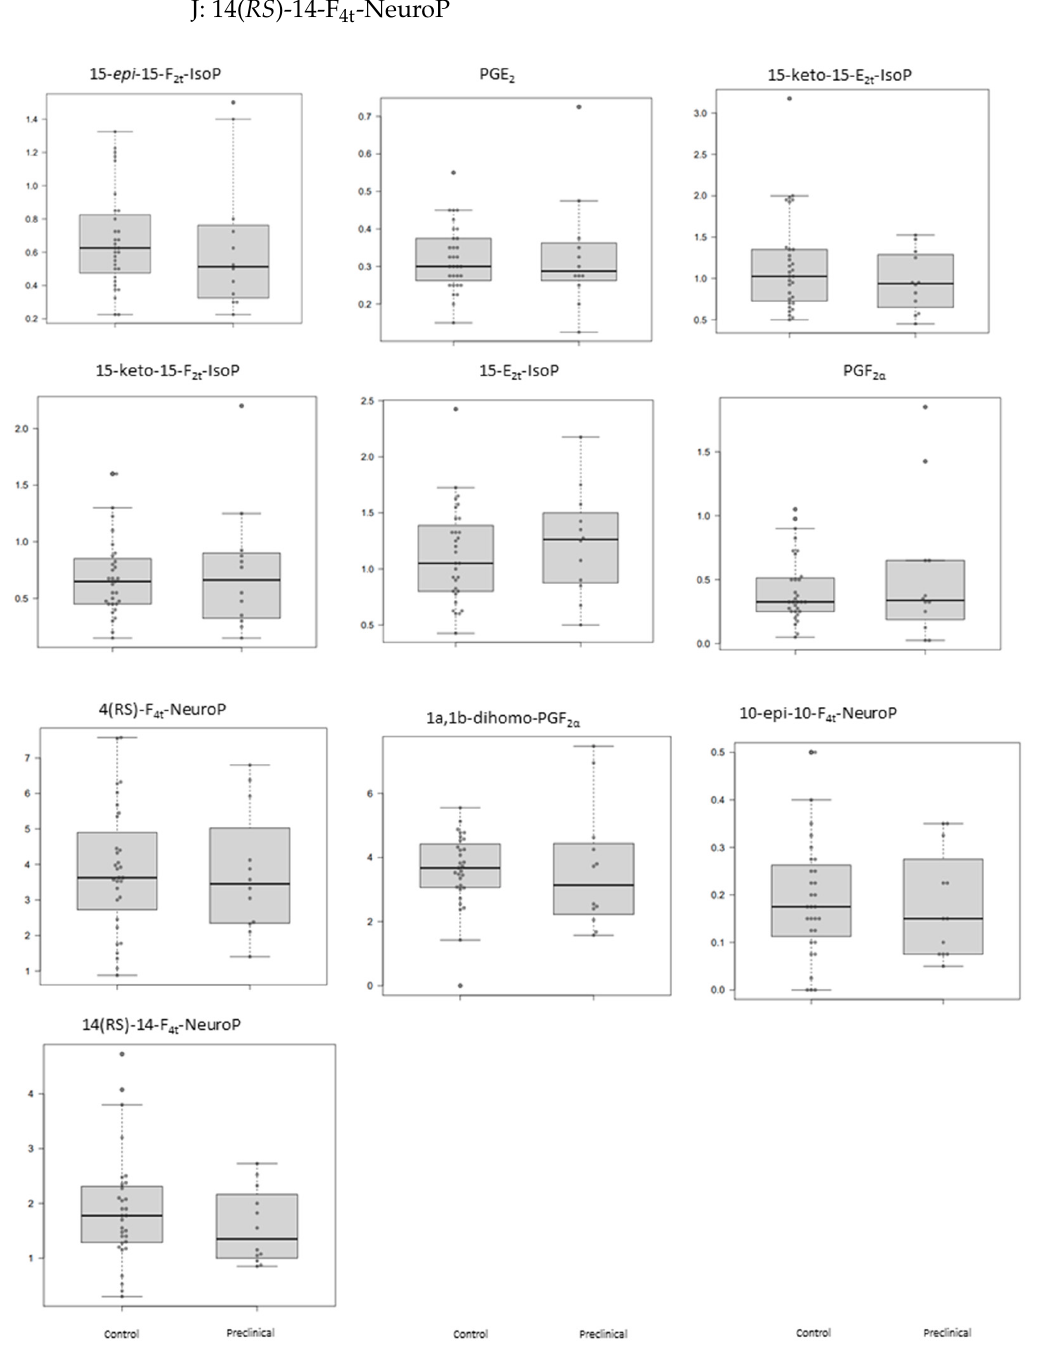
Figure 1. Box plots representing the concentrations in plasma samples for each analyte in control and preclinical-AD groups. Boxes represent the 1st and 3rd quartiles, and the black lines, the